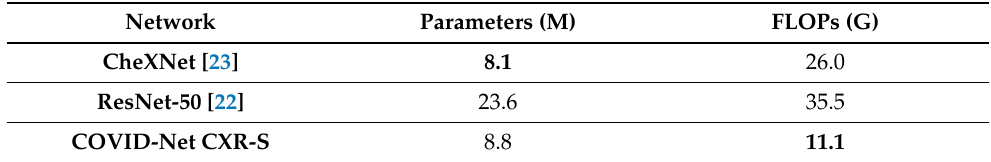
Table 4. Architectural and computational complexity of the proposed COVID-Net CXR-S, CheXNet [23], and ResNet-50 [22]. Best numbers are highlighted in bold.